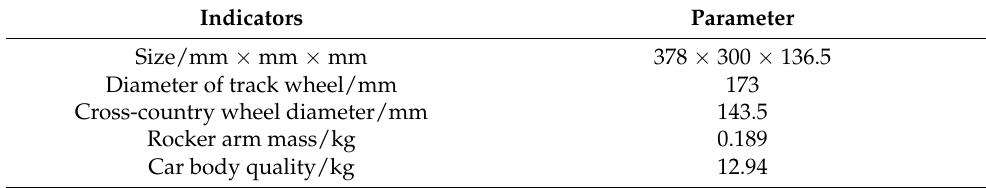
Table 1. Structural parameters of a four-track twin-rocker mobile robot.